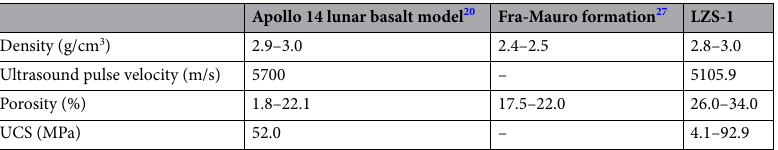
Table 7. Comparison of physical properties between a lunar basaltic model, the Fra Mauro formation, and the